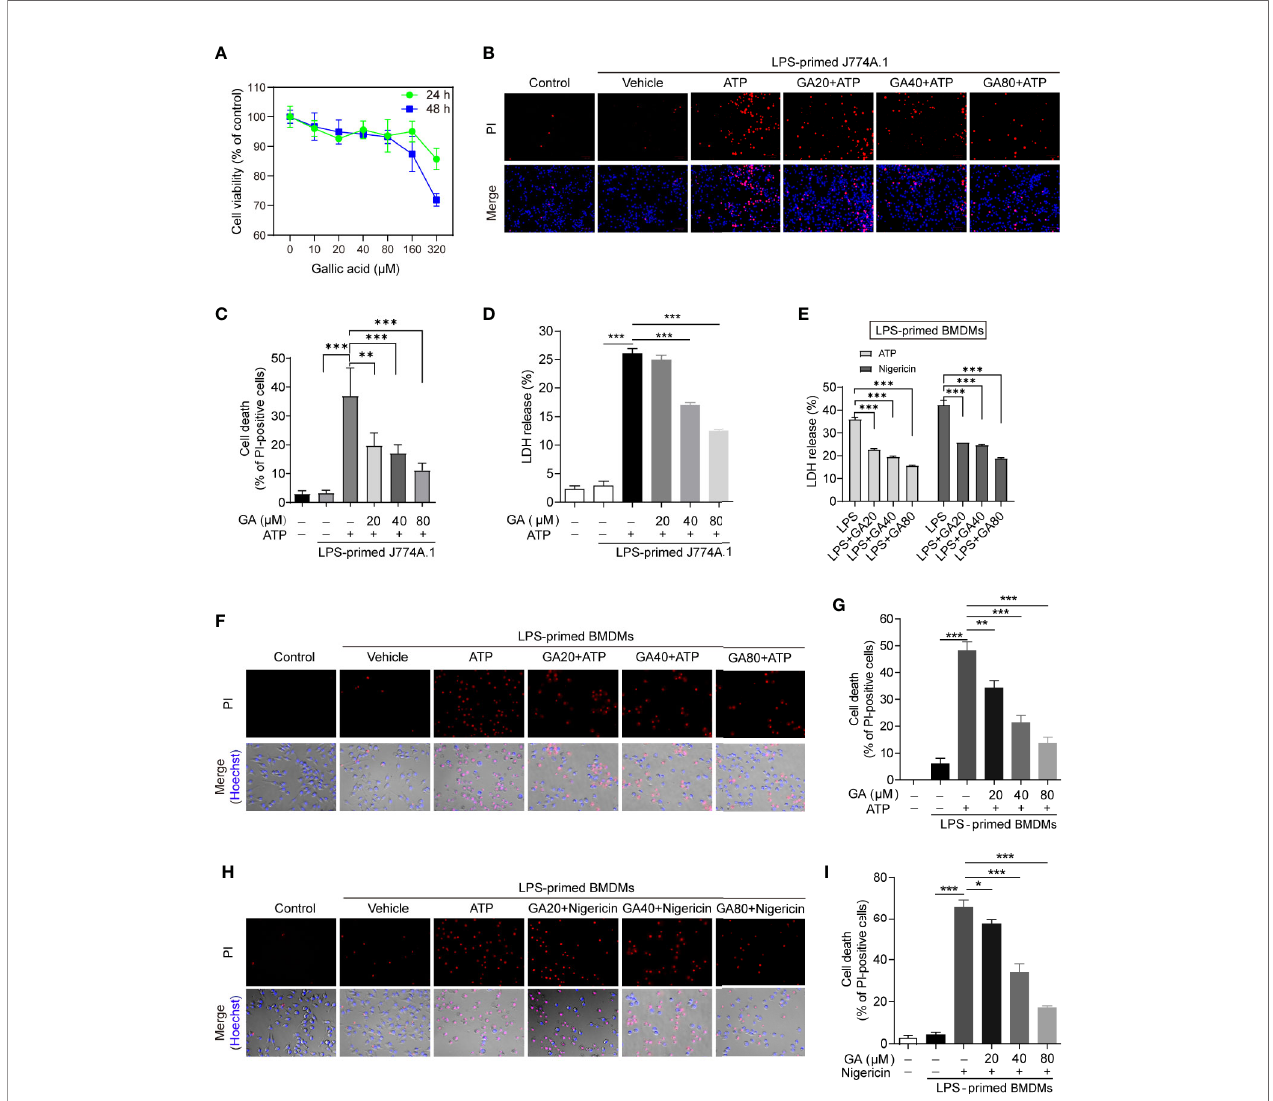
FIGURE 1 | Gallic acid prevents cell death in lipopolysaccharide (LPS)-primed and NLRP3 stimuli-treated macrophages. (A) J774A.1 cell were treated with gallic acid for 24 or 48 h, and then cytotoxicity was detected by CCK-8 assay. (B – D) J774A.1 cell were primed with LPS (500 ng/ml) for 4 h and then stimulated with ATP (3 mM) for 1 h with or without gallic acid. (E – I) LPS-primed bone marrow-derived macrophages (BMDMs) were incubated with gallic acid for 30 min and then stimulated with ATP (3 mM) or nigericin (10 m M) for 1 h. (D, E) The culture supernatant was collected to analyze lactate dehydrogenase (LDH) secretion. (B, F, H) Representative immuno fl uorescence images of cell death as detected by propidium iodide (PI) and Hoechst 33342 staining. (C, G, I) The percentage of PI-positive cells relative to all cells was calculated; 10 randomly chosen fi elds were quanti fi ed. GA, gallic acid. * P < 0.05, ** P < 0.01, *** P <